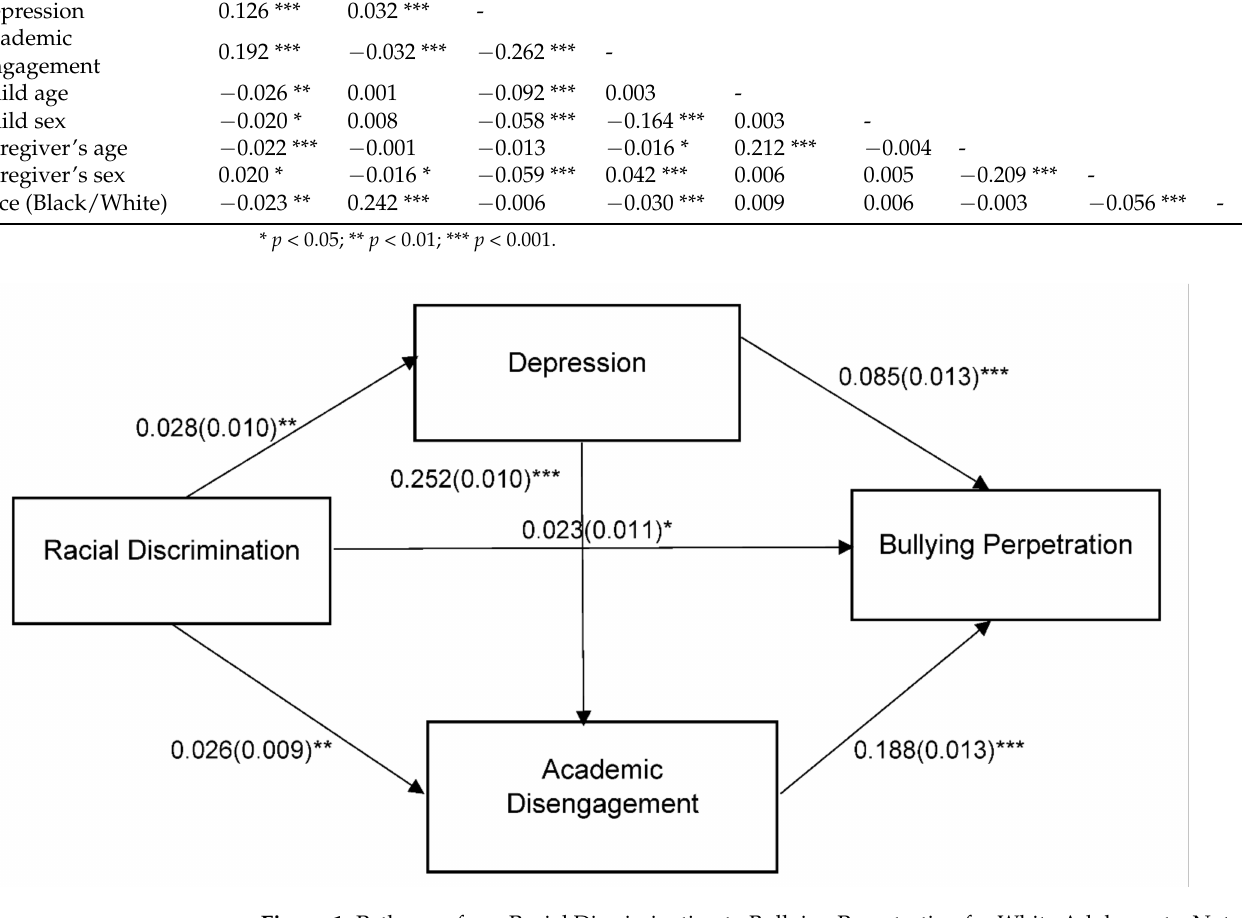
Figure 1. Pathways from Racial Discrimination to Bullying Perpetration for White Adolescents. Note: Controlled for child sex, child age, caregiver’s sex, and caregiver’s age; standardized coefficients are presented, and standard error is in the parentheses. * p < 0.05; ** p < 0.01; *** p <